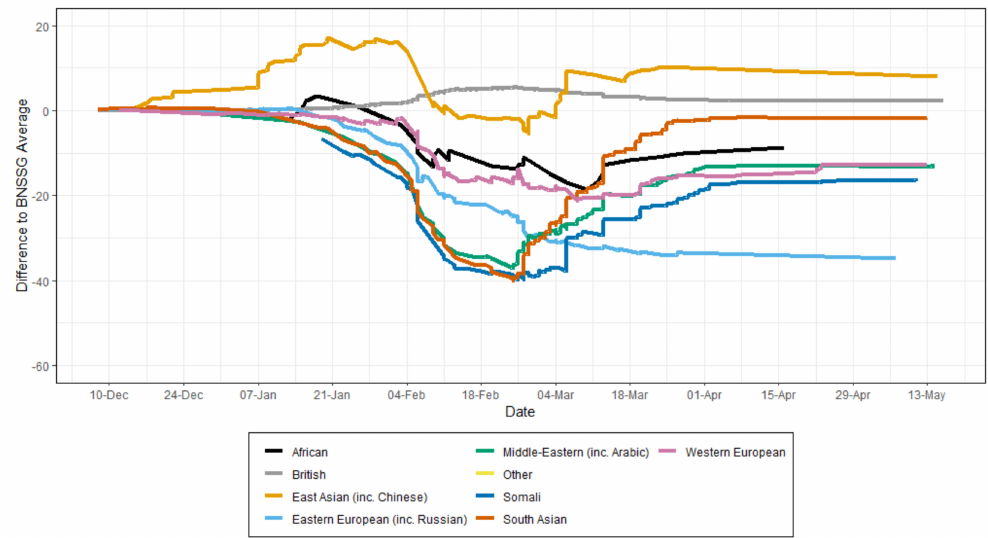
Figure 3. Percentage of vaccination uptake (first dose) by the first language group in the BNSSG area. JCVI (Joint Committee on Vaccination and Immunisation) priority groups for COVID-19 vaccination